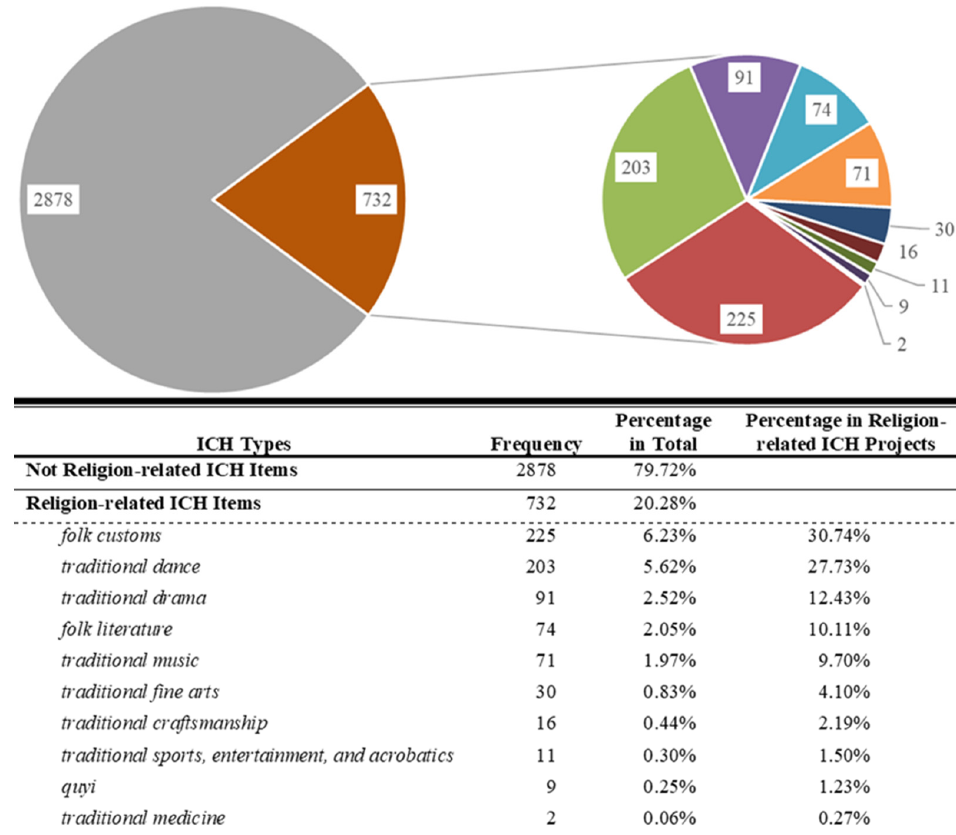
Figure 1. The Distribution of Different Types of Religion-related ICH Items in the National Inventories .